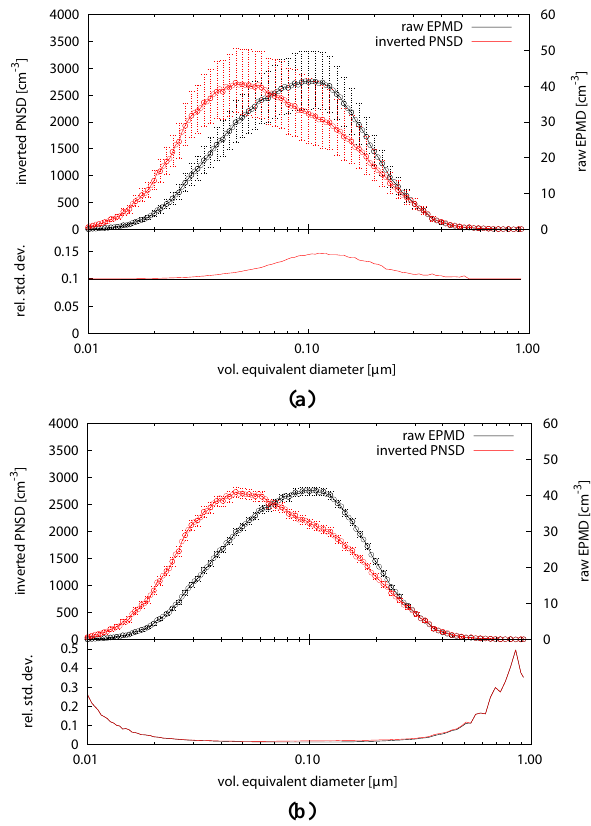
Fig. 4. Example of the error propagation of a mobility particle size spectrometer PNSD, Hohenpeissenberg, 23 February 2012, 1h av- erage 00:00–01:00LT – EPMD (black) in plain concentration (sec- ondary y axis) and PNSD (red). (a) The fictive relative error of the results increases for sampling points influenced by multiple-charge correction from 10 to 15%. (b) The relative error of the result is not significantly different from the input in the case of Poisson counting